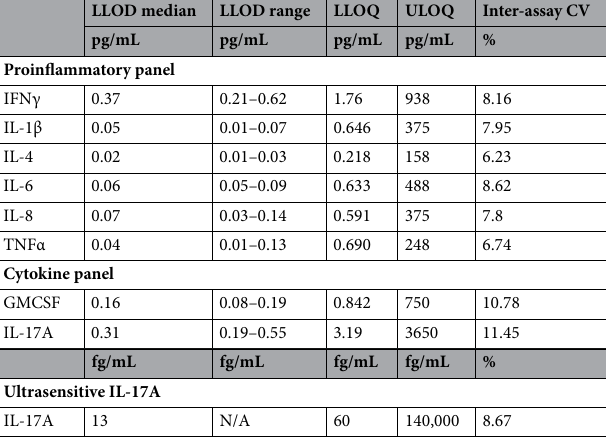
Table 1. Sensitivity of assays per each analyte examined. In this table LLOD, LLOQ, ULOQ for each analyte tested using the MSD proinflammatory panel 1, cytokine panel 1, and MSD S-plex Human IL-17A kits. The units of measurement used in the multiplex assays are pg/ml (10 −12 g (picograms) per millilitre), while the units in the ultrasensitive assay are fg/ml (10 −15 g (femtograms) per millilitre). The quantitative range of the assay lies between the LLOQ and ULOQ. Inter-assay CV is a measure of the variance between runs of sample replicates on different plates and assesses plate-to-plate consistency—inter-assay CV values < 15% were deemed acceptible 42 . All inter-assay CVs were within the permissible range, indicating a low level of plate-to-plate